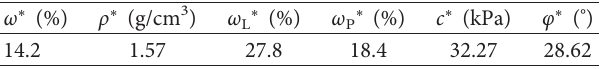
Table 1: Test results of the physical properties of loess in its natural state.